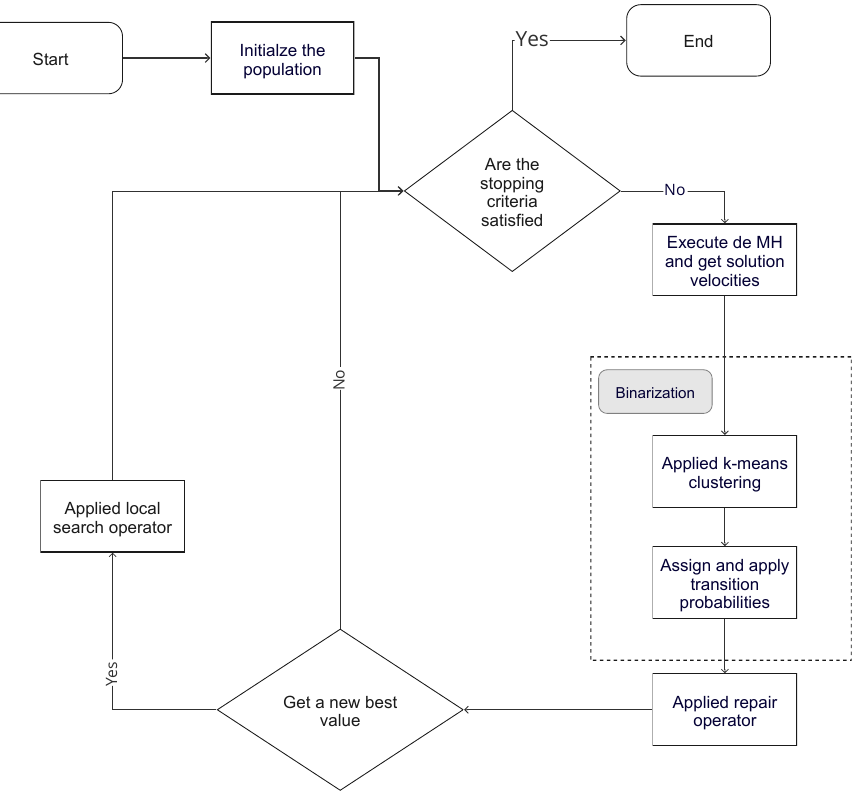
Figure 1. The proposed machine learning swarm intelligence